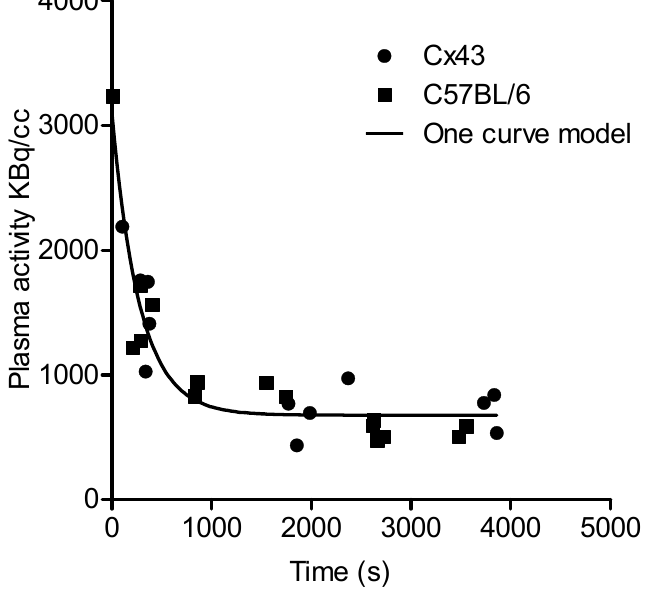
Figure 4. [ 18 F]FEPPA arterial input function from Cx43 and C57BL/6 mice and the one curve model for all data sets.